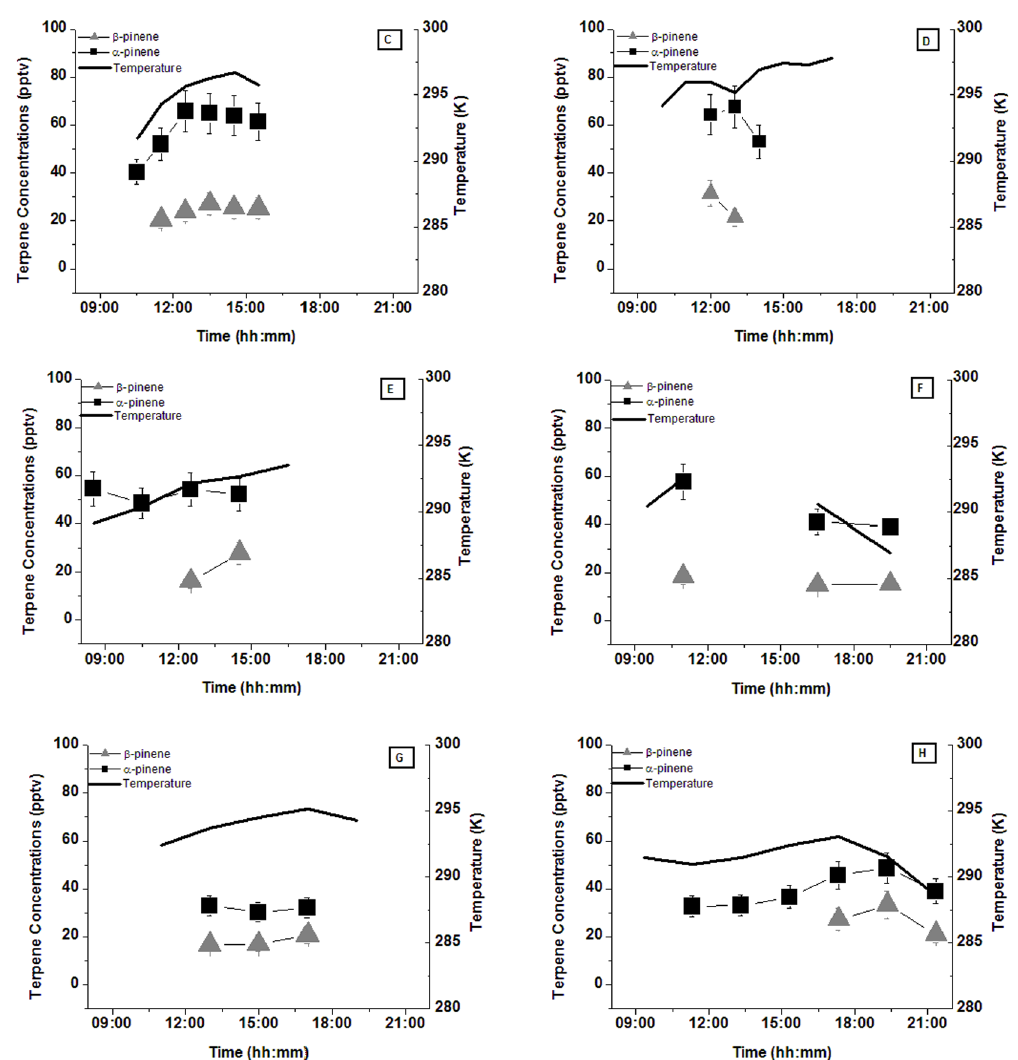
Fig. 7. Concentrations of α - and β -pinene measured via DEA during six intensives of the CABINEX 2009 campaign. Data show very low concentrations owing to the nature of this forest site as the forest is dominated by isoprene-emitting trees rather than terpene-emitting species. Error bars represent the propagated uncertainty associated with the monoterpene measurements. The secondary axis represents change in ambient temperature over the course of the